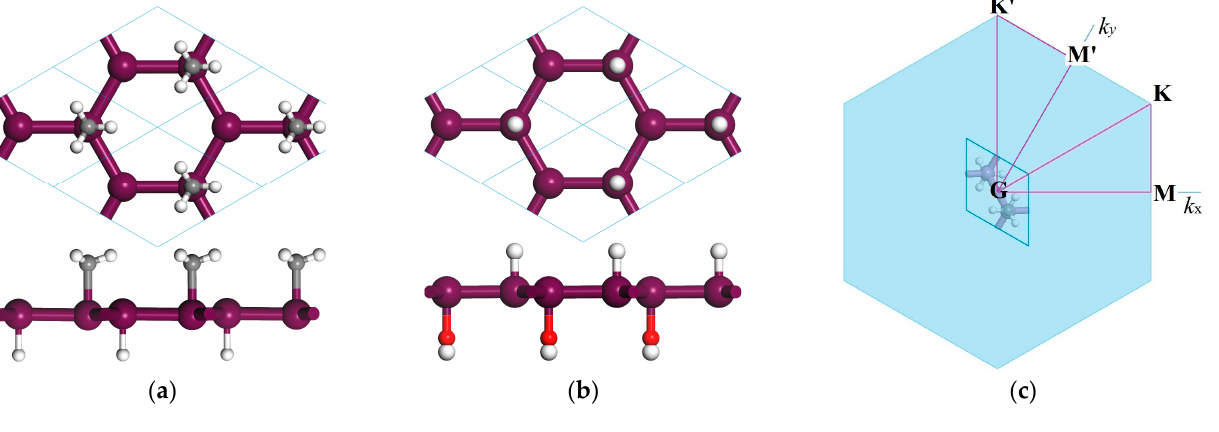
Figure 1. ( a , b ) Top-view (top) and side-view (bottom) schematics of Janus Sb or Bi monolayers with asymmetrical decorations of H and CH 3 or OH on two surface sides, respectively, where the violet, gray, red and white balls symbolize the bonding atoms of Sb or Bi, C, O and H, respectively; ( c ) high-symmetry points (M, K, M ′ , K ′ ) specifying the dispersion paths of phonon frequency or electron energy in Brillouin zone. Table 1. Lattice constants a , bond lengths of Sb or Bi with center atoms of CH 3 or OH ( d MX ), center buckle thickness ( h M ), entire layer thickness ( h ), cohesive energy ( E coh ), Mulliken population charge ( q M ) where M 1 and M 2 indicate two atoms of Sb or Bi and X denotes the functional-group center atom (C or O) or the H atom (for SbH and BiH only) of Janus Sb and Bi monolayers together with the SbH and BiH monolayers for comparison.